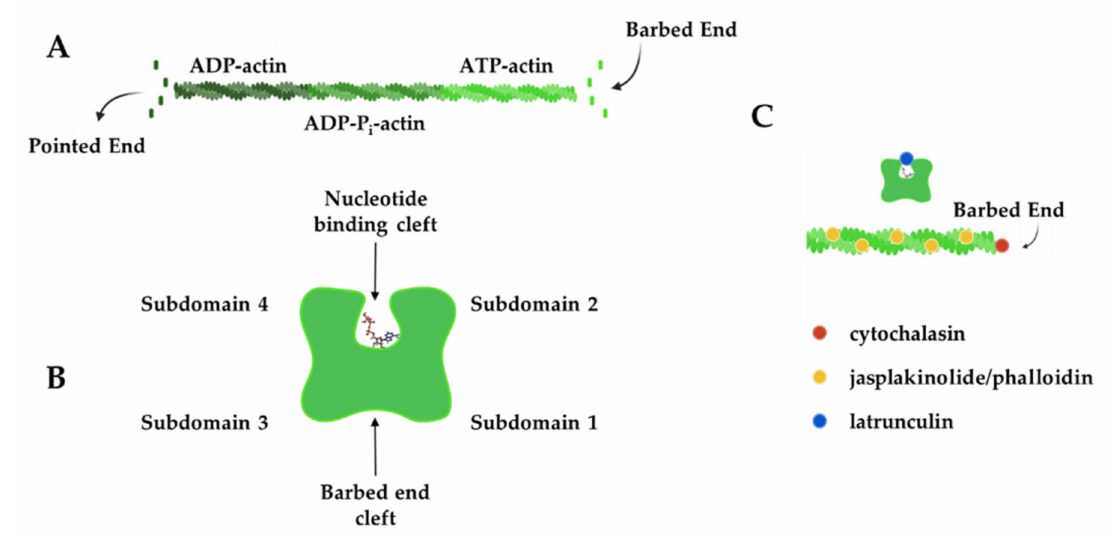
Figure 2. Actin filament dynamics can be modulated by chemical compounds. ( A ) Actin monomers add to the barbed end of actin filaments in an ATP-bound form, while ADP-actin monomers dissociate from the pointed end to create filament treadmilling. ( B ) Actin monomers have four subdomains that are split by a nucleotide-binding cleft. Subdomains 1 and 3 come together to form the barbed-end cleft where many actin-binding proteins interact. ( C ) Chemical compounds can be used to modulate actin dynamics by binding to the barbed end of the filament (cytochalasins), near the nucleotide- binding cleft (latrunculins) of monomers or along the length of actin filaments (jasplakinolide and phalloidin) to exert their effect. Actin filaments in B and C were created and retrieved from https: //app.biorender.com/biorender-templates (accessed on 28 January 2022). Table 1. The effect of actin inhibitors on filament